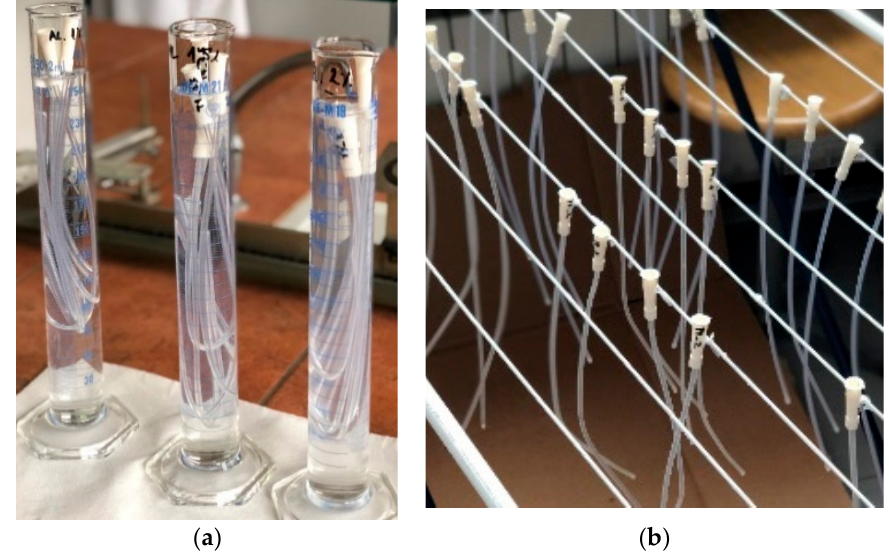
Figure 13. ( a ) Soaking of catheters in coating solution and ( b ) drying of